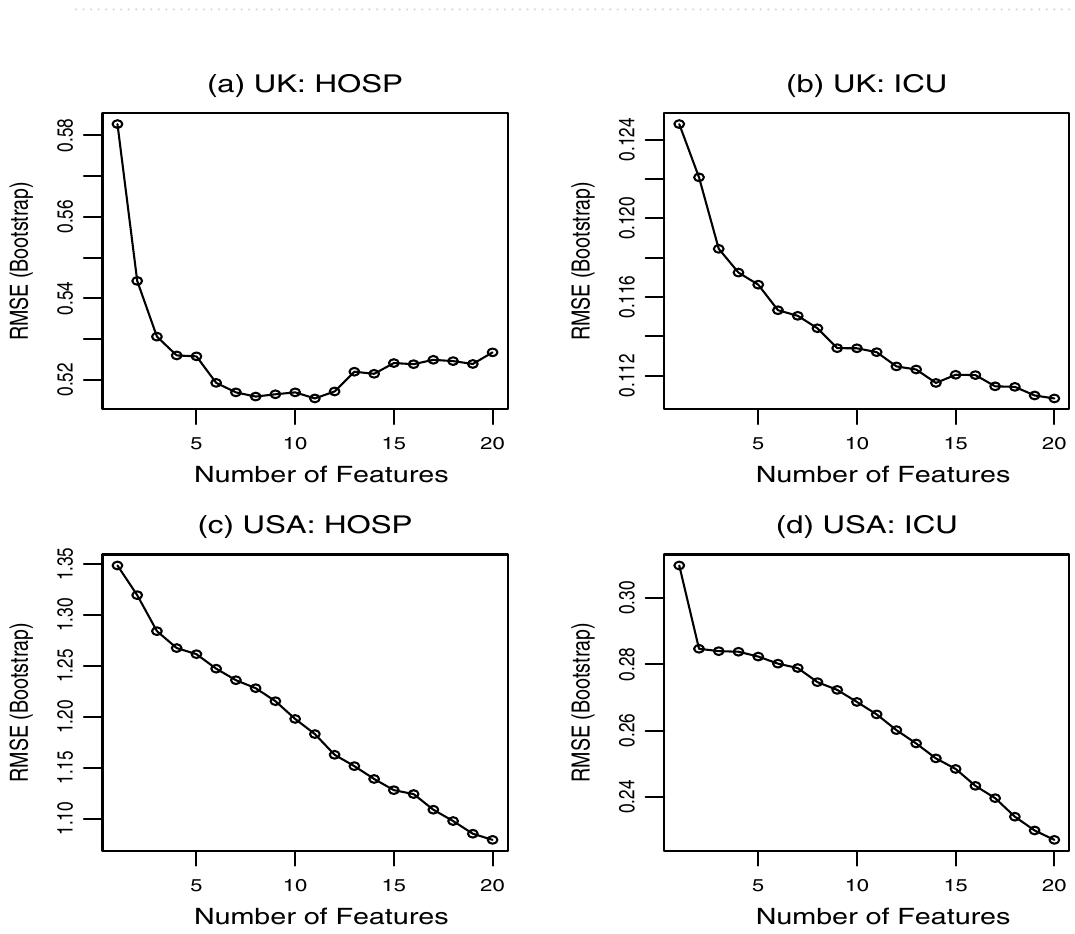
Figure 7. Number of features selected by recursive feature elimination in SVR model of (cid:31) HOSP t and (cid:31) ICU t for distributed lags of (cid:31) VAC t − k in USA and UK, where k = 1, . . . , 20 . Distributed lags { 2, 3, 4, 9, 10, 11, 17, 18 } are selected for ( a ), and { 1, 2, . . . , 20 } are required for figures in ( b )–( d